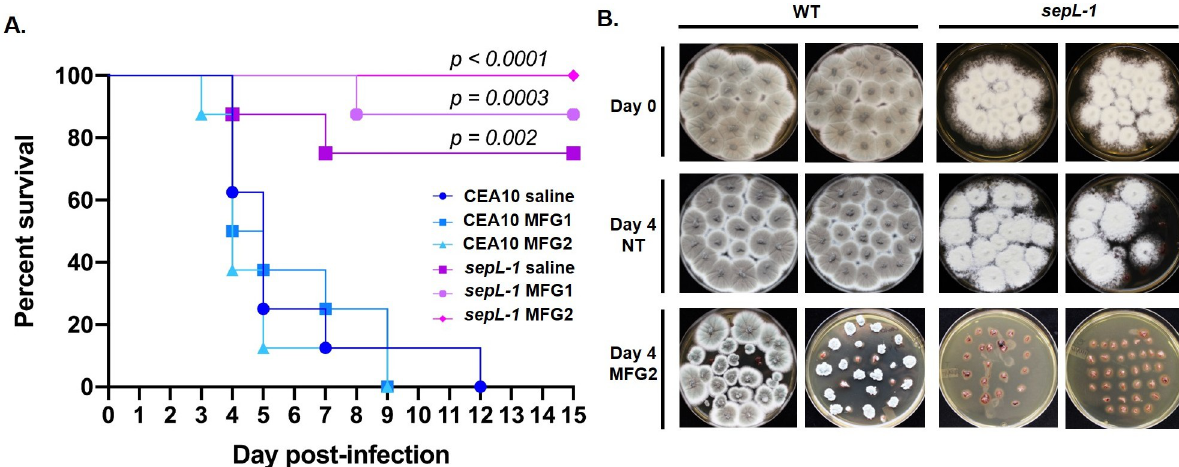
Fig 10. Loss of hyphal septation improves echinocandin therapy characterized by clearance of fungal burden from lung tissue. A) Survival analysis of mice infected with either the CEA10 or sepL-1 mutant strain with and without micafungin therapy. All mice were immune suppressed through intraperitoneal injection of cyclophosphamide on days -3, +1, +4, and +7 and a single subcutaneous injection of triamcinolone acetonide on day -1. Mice were inoculated with 1 X 10 6 conidia of the indicated strain suspended in 20 μ l of sterile saline on day 0 and then received three separate intraperitoneal injections of micafungin at either 1 mg/kg (MFG1) or 2 mg/kg (MFG2) on days +1, +2 and +3. Statistical comparisons were made by Mantel-Cox log-rank test and represent each sepL-1 mutant experimental arm compared to its CEA10 control (i.e., CEA10 saline vs . sepL-1 saline, CEA10 MFG1 vs . sepL-1 MFG1, and CEA10 MFG2 vs . sepL-1 MFG2). B) CEA10 and sepL-1 residual lung tissue burden at day 0 and day 4 with and without micafungin 2 mg/kg therapy. Organ cultures are shown from two representative animals from each treatment group. Note that the sepL-1 infected mice treated with micafungin 2 mg/kg are culture negative at day 4 post-inoculation. MFG = micafungin.